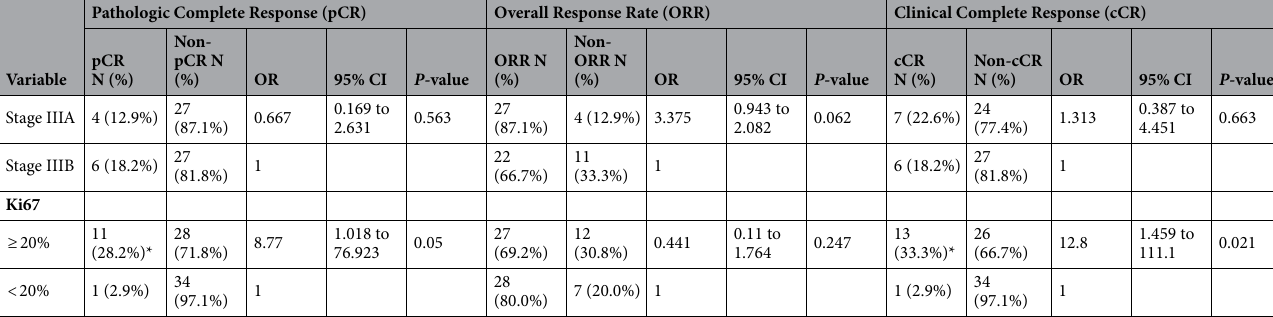
Table 2. Univariate analysis of variables associated with response according to the different endpoints. OR Odds Ratio, BMI body mass index, ER estrogen receptor, PgR progesterone receptor, HER2 human epidermal growth factor receptor 2, Ki67 proliferation index. *Significant as compared to the control group at P -value ≤ 0.05, CI: 95% confidence interval. ** Significant as compared to the control group at P -value ≤ 0.01, CI: 95% confidence interval.